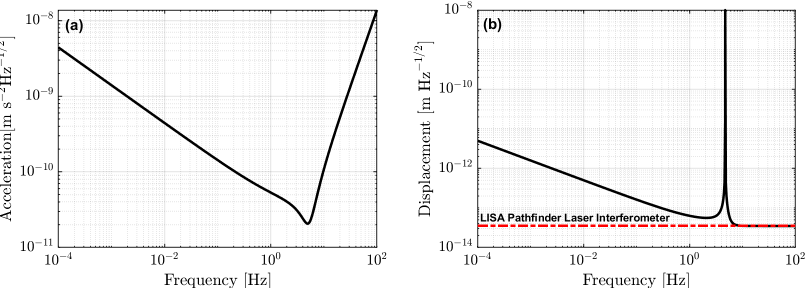
Figure 6. ( a ) The acceleration noise floor of our optomechanical accelerometer including thermal motion from the resonator and readout noise from the laser interferometer. ( b ) The corresponding displacement readout noise floor required to observe this acceleration noise level. Both plots assume a mechanical Q -factor of 4.76 × 10 5 and a readout noise consistent with that achieved by LISA Pathfinder [30].